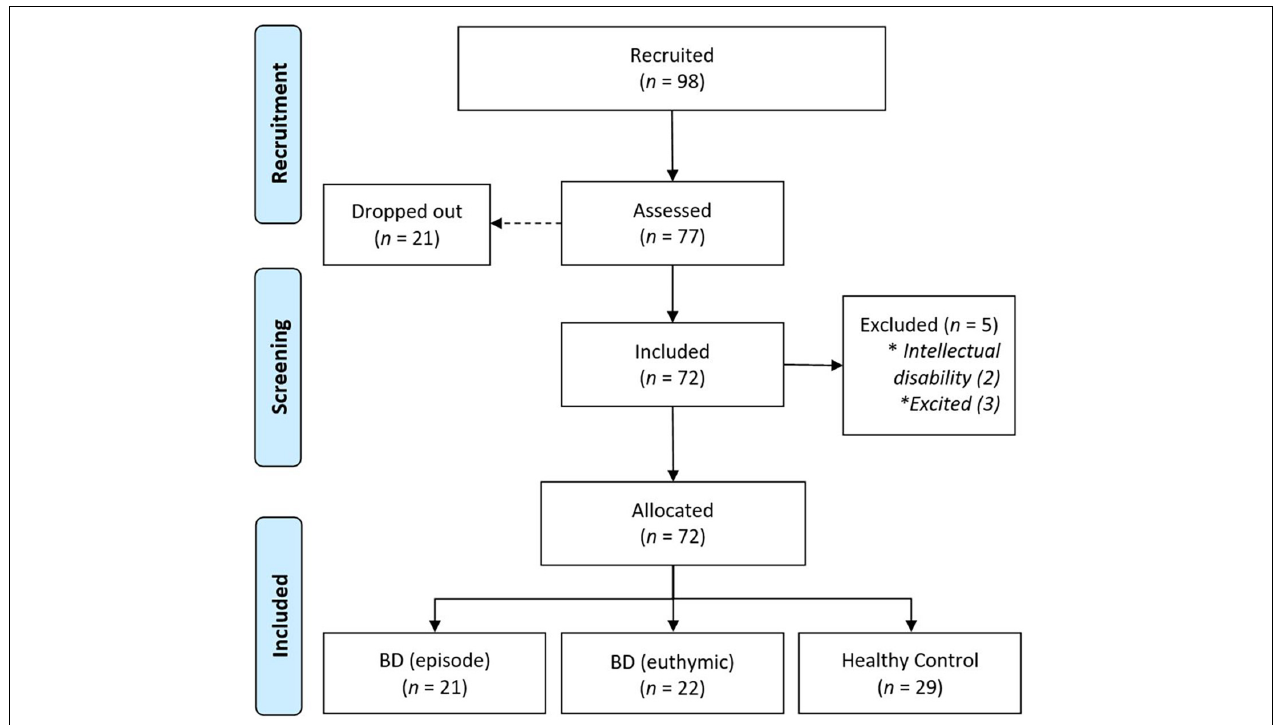
FIGURE 1 | Flowdiagram of the selection and inclusion of the